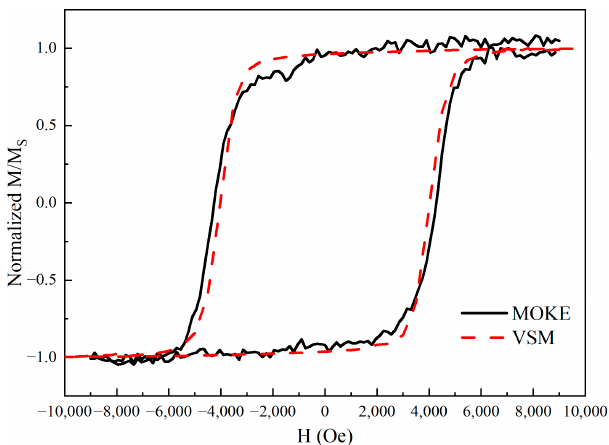
Figure 1. Measurement of the normalized out-of-plane hysteresis loops. The dash and solid loops are measured by VSM and MOKE, respectively.